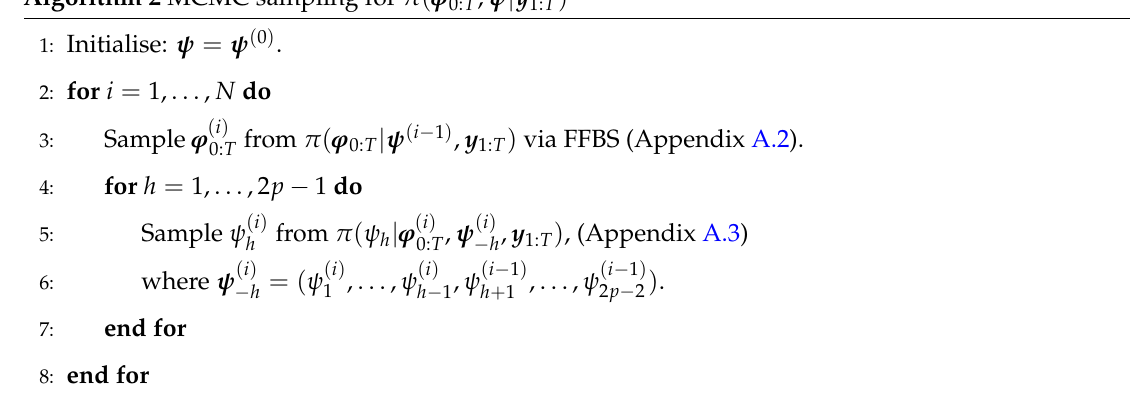
Algorithm 2 MCMC sampling for π ( ϕ 0: T , ψ | y 1: T